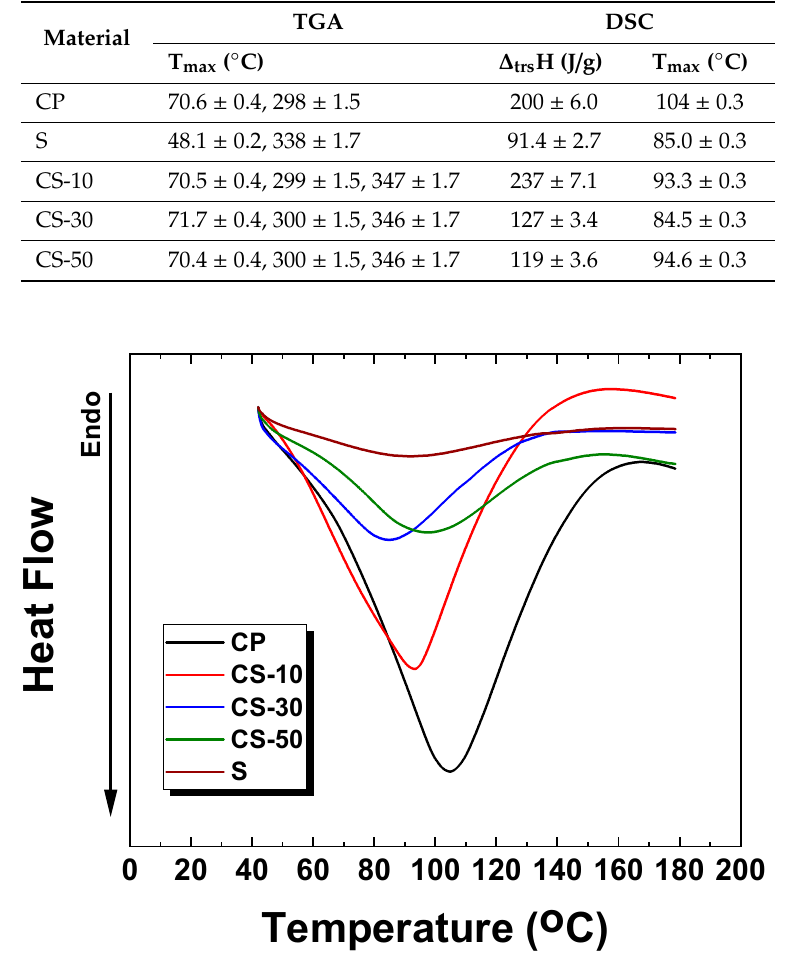
Figure 4. Differential scanning calorimetry (DSC) for CP, S, CS-10, CS-30, and CS-50 samples. Figure 4. Di ff erential scanning calorimetry (DSC) for CP, S, CS-10, CS-30, and CS-50